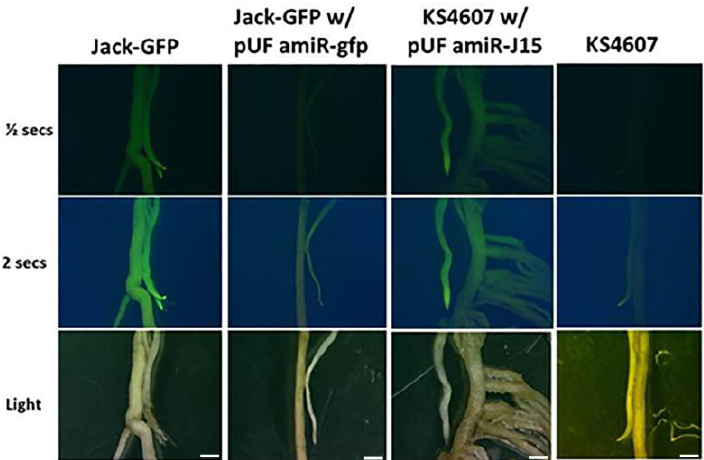
Figure 2. Validation of the pUFamiR vector. Row 1 and Row 2: visualization of GFP expression observed under blue light. Row 3: roots observed under white light. Column 1: roots from a transgenic soybean cultivar “Jack” expressing GFP. Column 2: Jack-GFP line transformed with pUFamiR-gfp. Column 3: cultivar KS4607 transformed with pUFamiR-J15. Column 4: nontransformed control KS4607. Scale Bar = 1 mm.